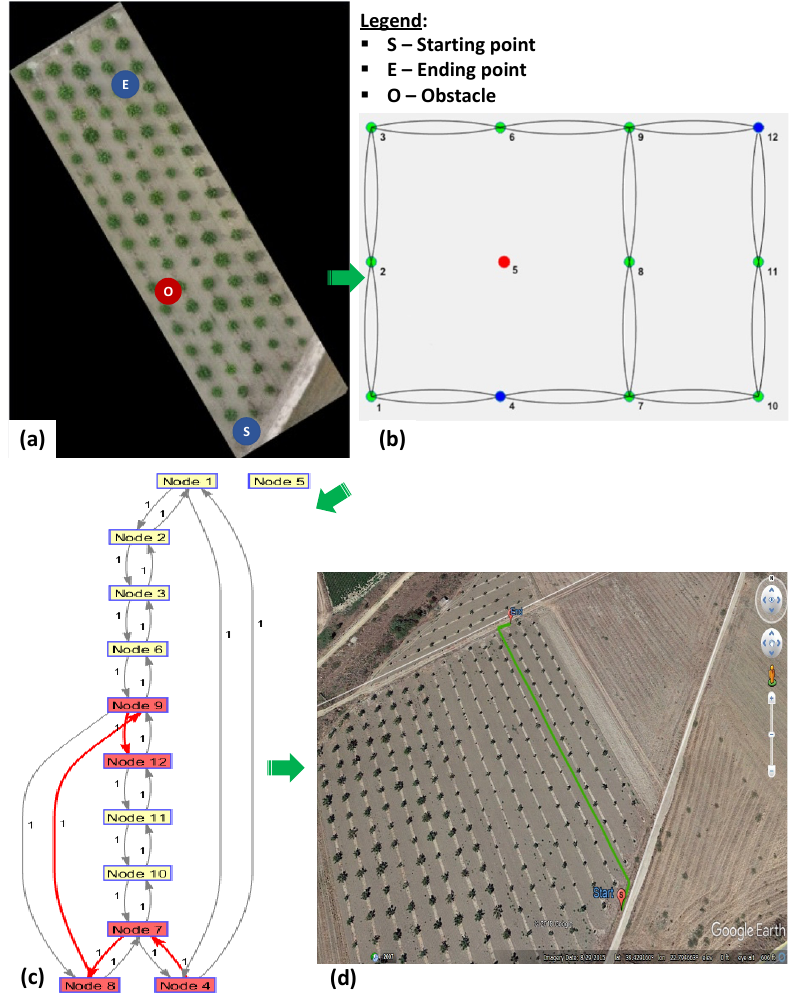
Figure 14. Route planning, Scenario #1: ( a ) initial map; ( b ) topological grid; ( c ) graph; and ( d ) optimal path plan.